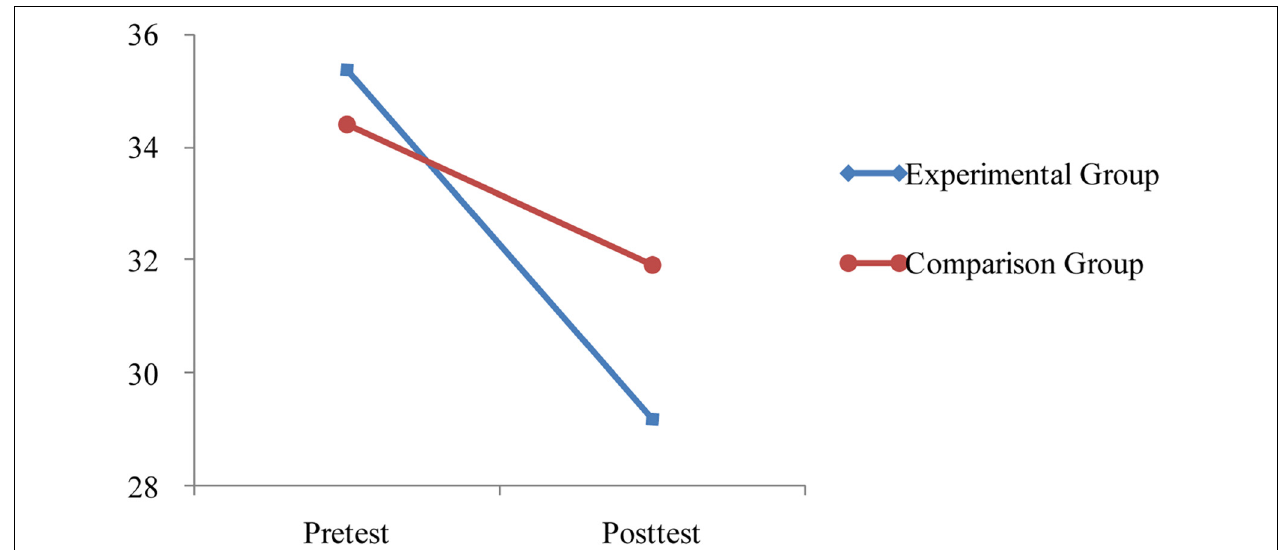
FIGURE 1 | The time × group